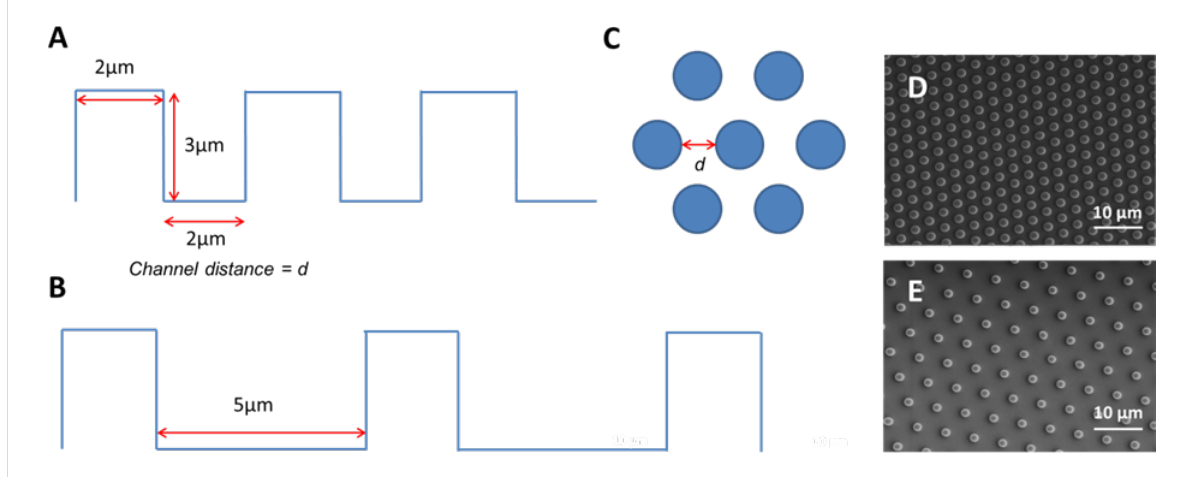
Figure 10: Diagram illustrating the topography of the PDMS structured surfaces. Each pillar on the surface has the same height and diameter, but varies in the gap between each pillar (d). Images A and B display gaps of 2 and 5 µm respectively, while image C shows the layout of pillars from above. Images D and E (gaps of 2 and 5 µm respectively) are SEM images of examples of the PDMS structured